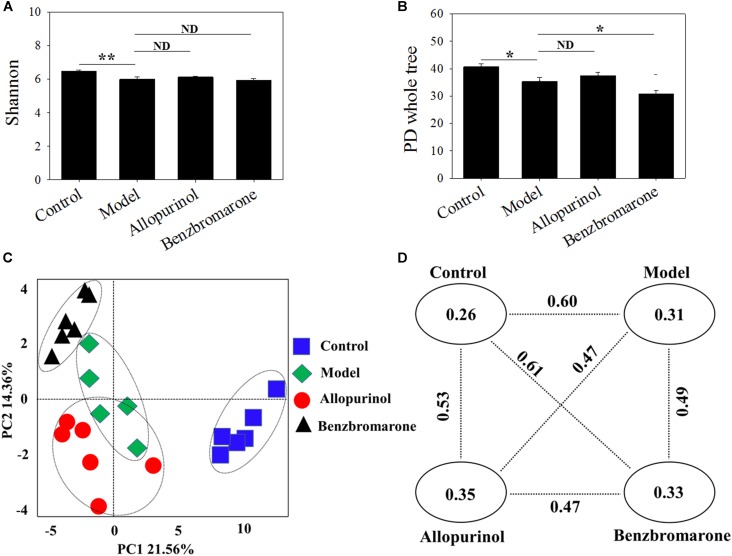
Alpha diversity indices [Shannon (A); PD Whole Tree (B)] and Beta diversity [PCoA score plots (C); unweighted UniFrac distance (D)] of male rats in the four groups. “∗” represents the adjusted p value <0.05 between two groups; “∗∗” represents the adjusted p value <0.01 between two groups; “ND” represents the adjusted p value >0.05 between groups.